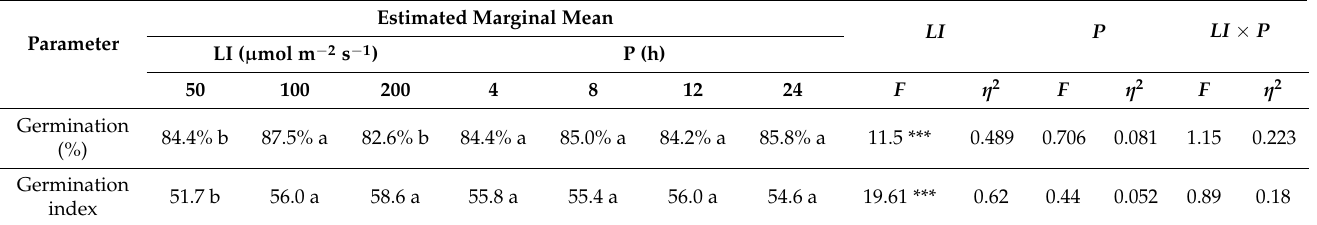
Table 1. Multivariate analysis of variance results for the effects of light intensity (LI) and photoperiod (P) on germination rate and germination index of celery seed.